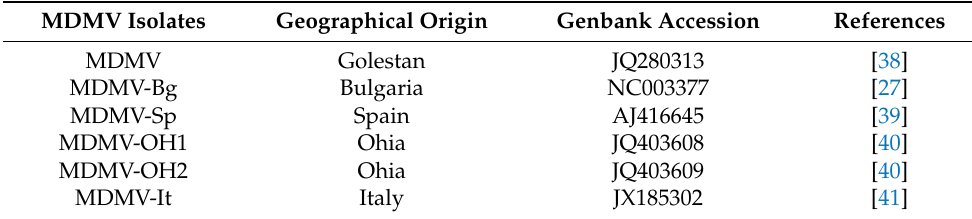
Table 1. Available complete sequences of maize dwarf mosaic virus (MDMV)